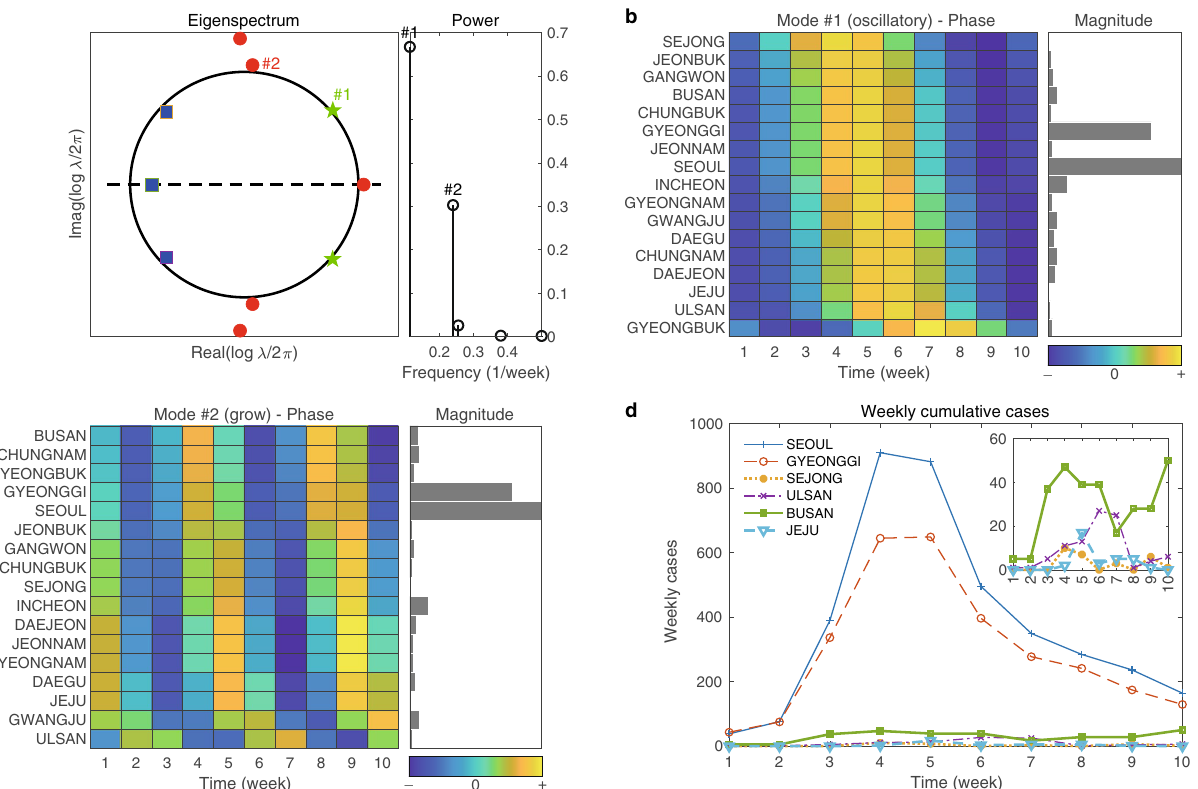
Figure 4. The second wave: DMD eigenvalues and modes. ( a ) shows eigenspectrum { (cid:31) j } j = 1, ··· in the left and p |� α j φ j � F } j = 1, ··· , in the right. The first two DMD modes of highest powers are enumerated powers, defined as {| (cid:31) j as #1 and #2 . ( b ) and ( c ) show phase and magnitude of the #1 and #2 DMD modes, respectively. In the phase diagram, regions, whose phases are similar are gathered. ( d ) is the time series for weekly cumulative cases for some selected